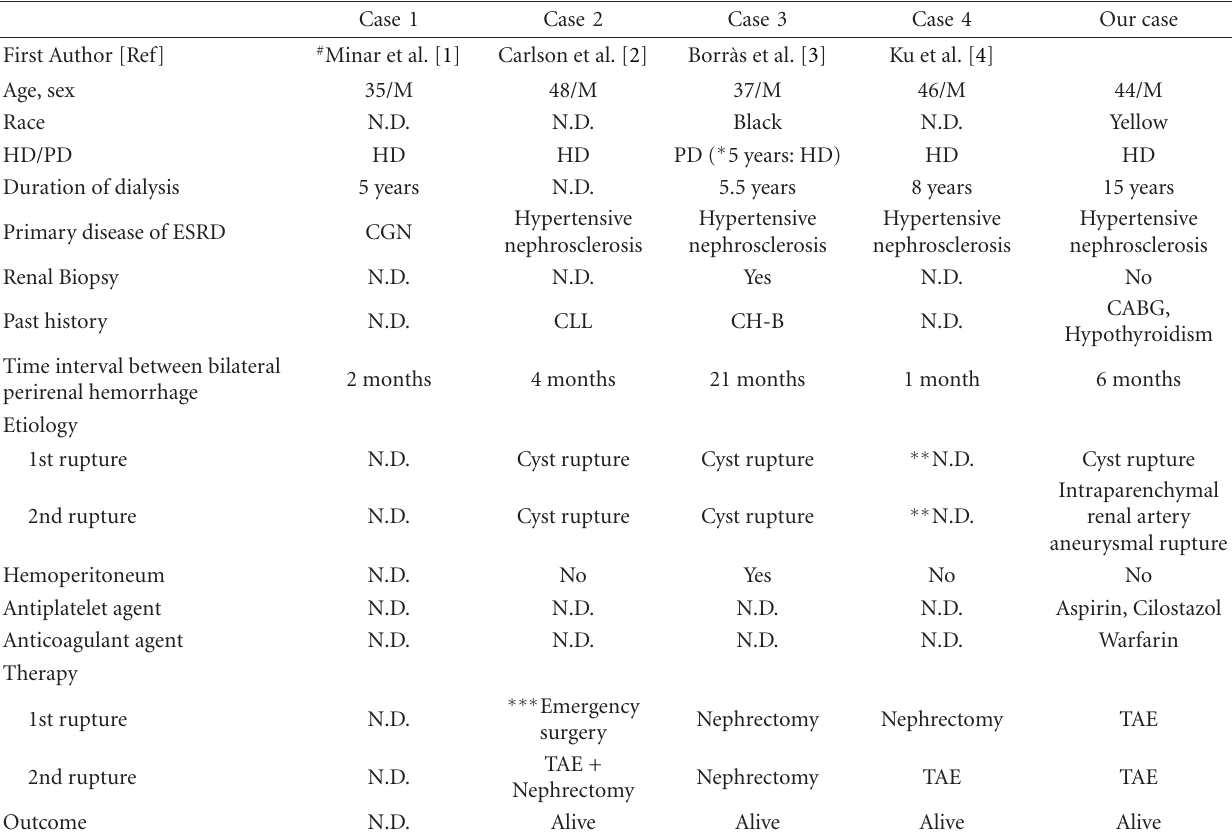
Table 1: Spontaneous bilateral perirenal hemorrhage in ACKD dialysis